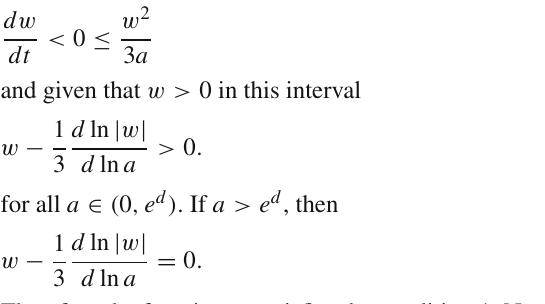
This EoSparameter mimics aquintessencescalar field( − 1